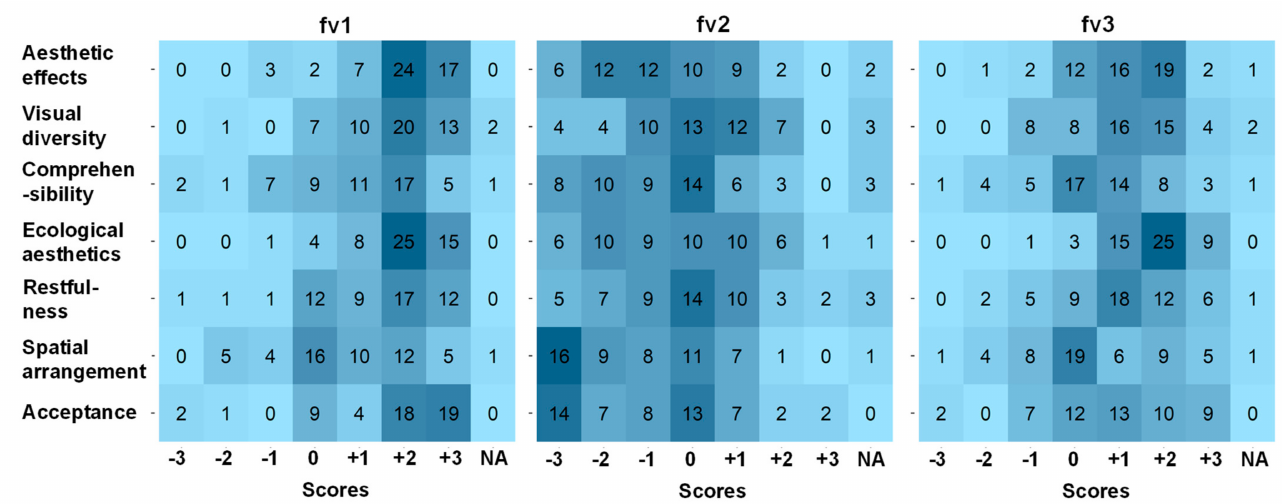
Figure 2. Heatmaps showing the frequencies of votes for the seven positively formulated components for the three different forest views (from left to right fv1—Norway spruce forests with regeneration of deciduous tree species in the background, fv2—Norway spruce forest without regeneration and fv3—Norway spruce forest with European beech as a second layer in the foreground of the